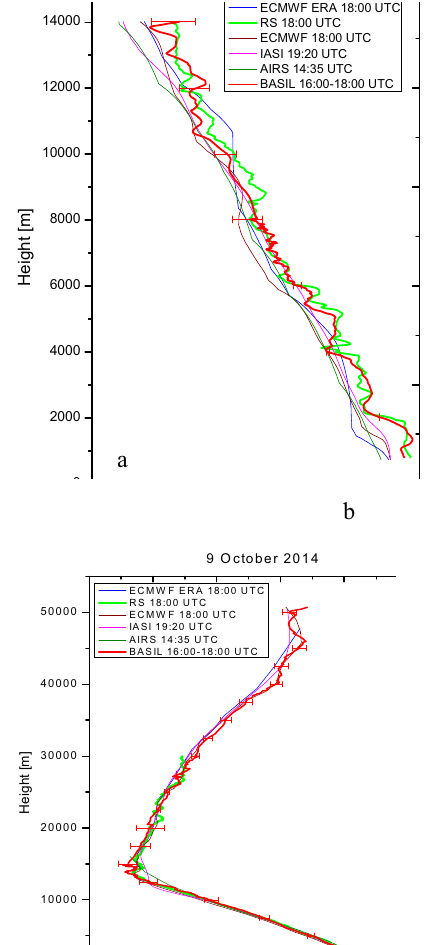
Fig. 1: Mean profile of water vapour mixing ratio (a) and temperature (b) as measured by BASIL over the time interval 16:00-18:00 UTC on 9 October 2014, together with the closest in time profiles from IASI (at 19:20 UTC), AIRS (at 14:35 UTC) and the model re- analysis ECMWF (ERA-15 & ERA-40, at 18:00 UTC). RMS deviation values for both water vapour mixing ratio and temperature for all sensor/model pairs (not shown here) are slightly larger than BIAS